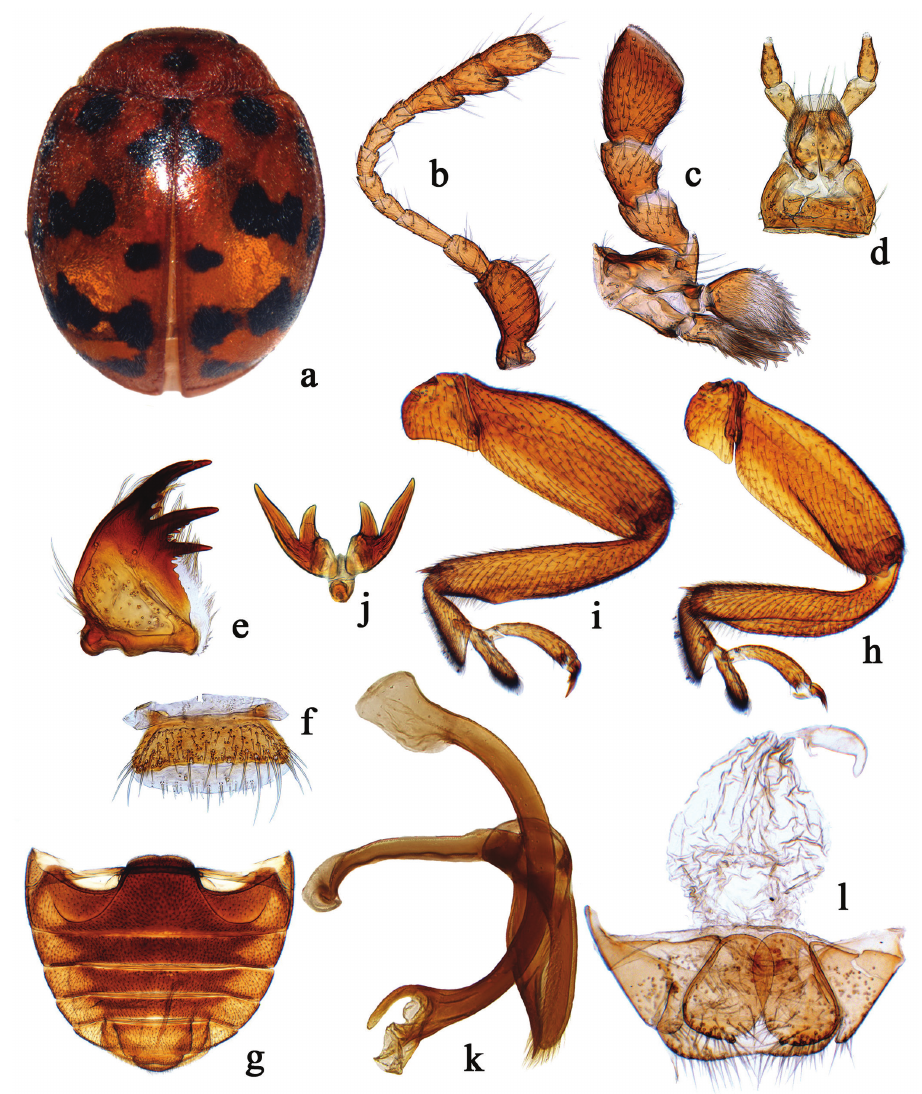
Figure 2. Morphological characters of the genus Subcoccinella . a–l Subcoccinella vigintiquatuorpunctata Linnaeus, 1758 From China. a dorsal habitus; b antenna c maxilla d labium e mandible f labrum g abdo- men h front leg i hind leg j tarsal claw k male genitalia: penis and tegmen l female genitalia: coxites and